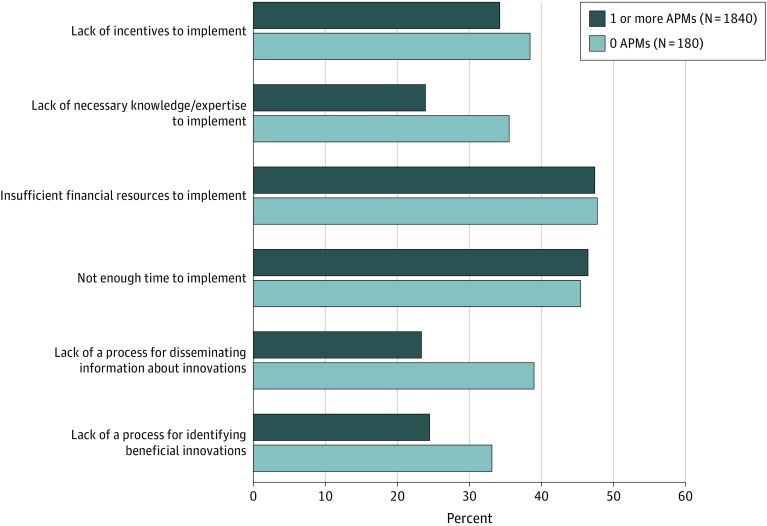
Major Barriers to Use of Evidence-Based Care Delivery Innovations by Participation in Alternative Payment Models Among 2020 Physician PracticesThe survey respondents were asked to choose among potential barriers to their practice's use of evidence-based care delivery innovations (eg, care transition programs, home visits, or community health workers). For each response option, the respondents specified whether that option constituted a major barrier, a minor barrier, or did not constitute a barrier for their practice.